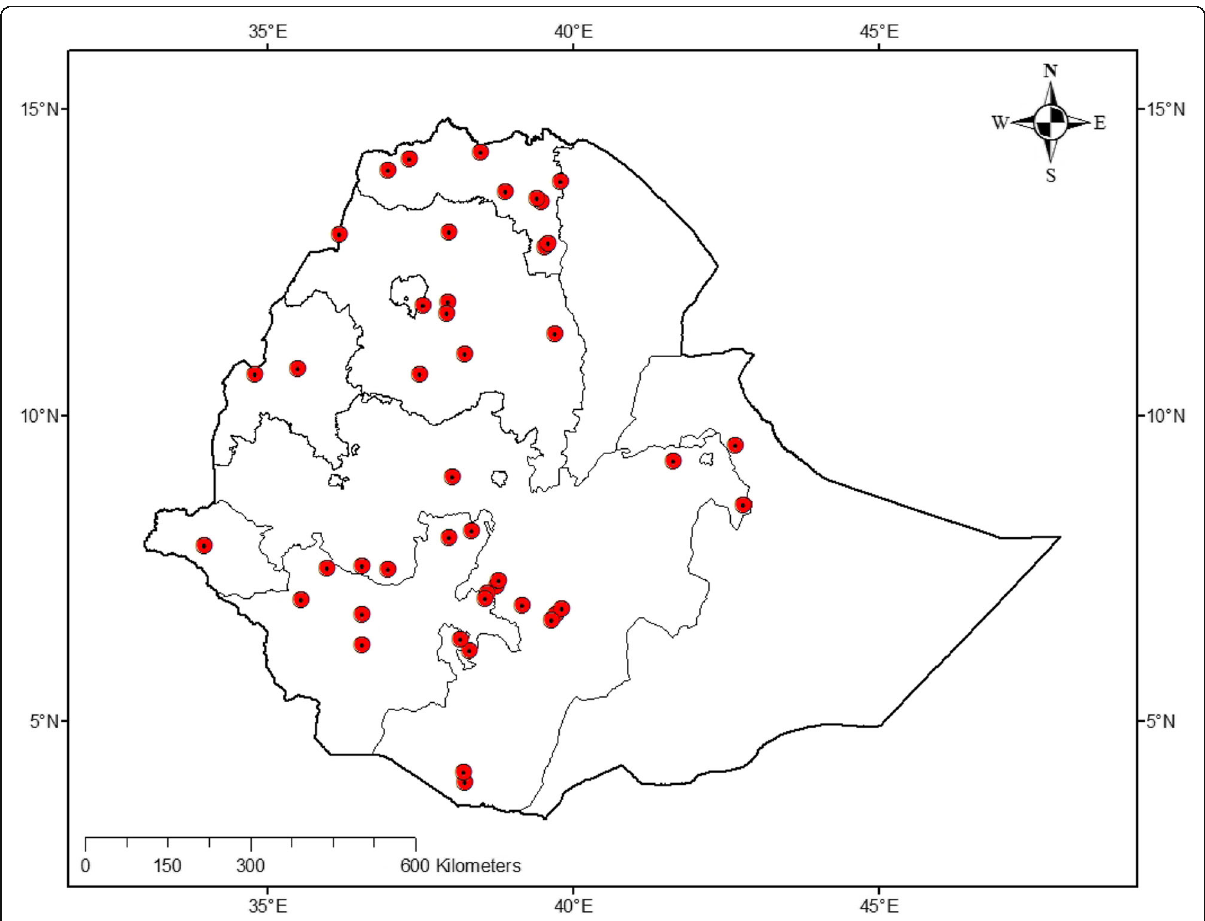
Fig. 1 Map of Ethiopia indicating the approximate location of the study sites referred to in this review as compiled from the